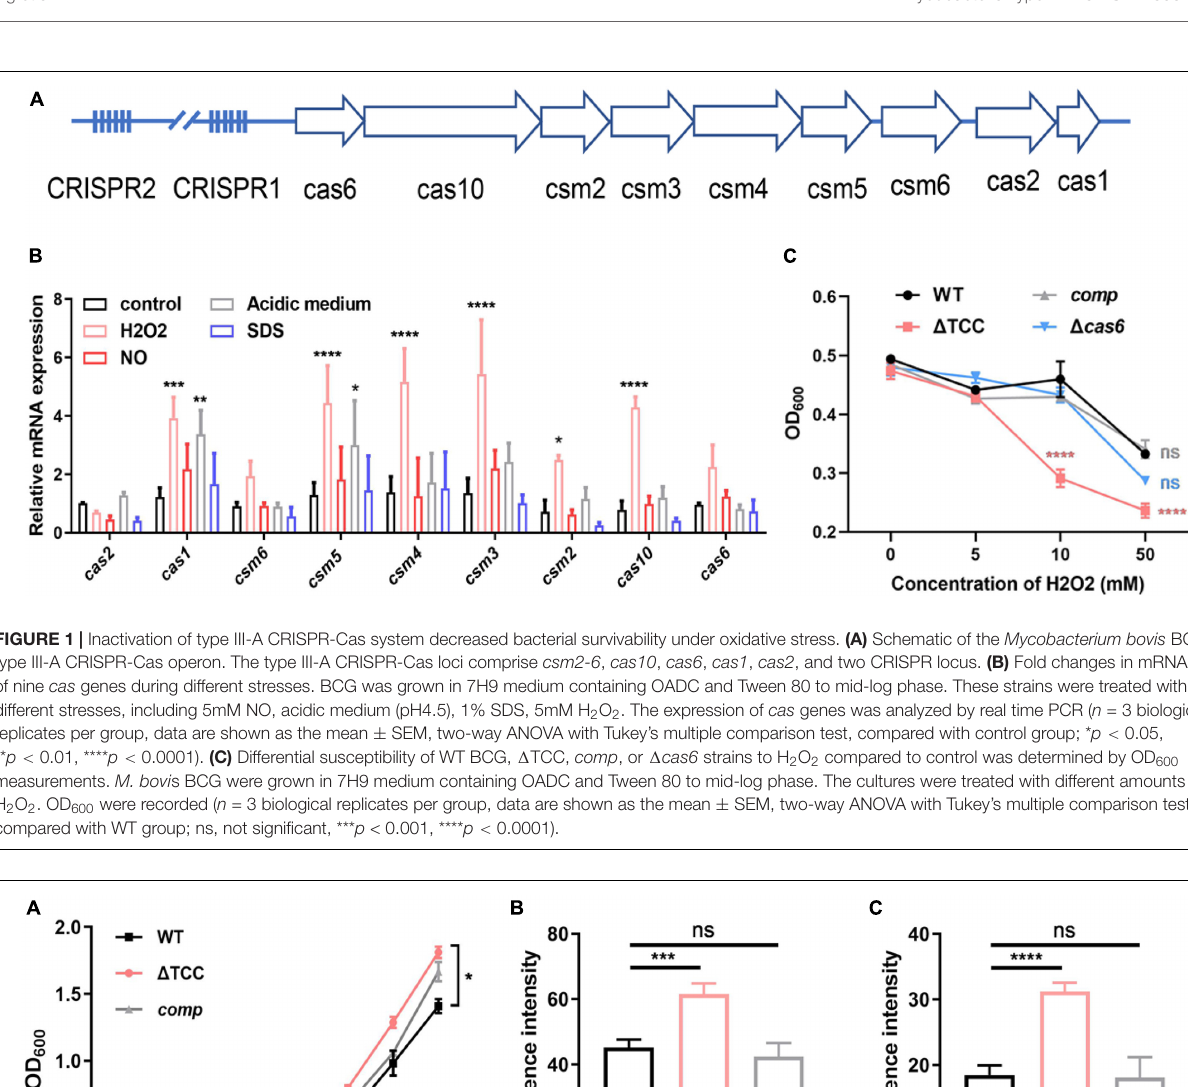
pathways (FDR > 0.05) are shown in Supplementary Table 4 .